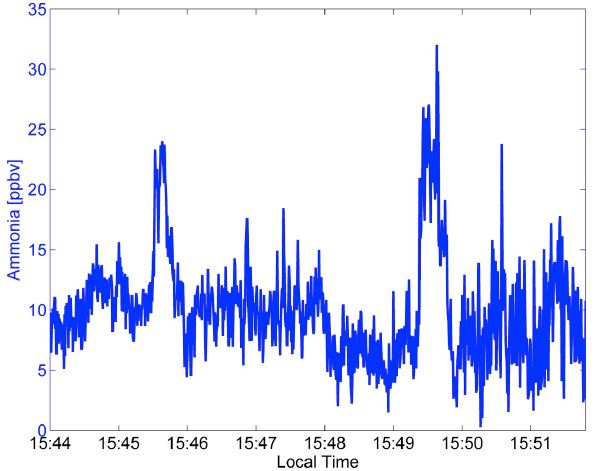
Fig. 10. On-road, mobile, open-path NH 3 measurements of high- Figure 10. On-road, mobile, open-path NH 3 measurements of highway vehicle emissions 2 way vehicle emissions recorded at 2Hz. The response time at recorded at 2 Hz. The response time at ppbv NH 3 mixing ratios is demonstrated for the 3 ppbv NH 3 mixing ratios is demonstrated for the emission spikes emission spikes at 15:45:40 and 15:49:30 local time. 4 at 15:45:40 and 15:49:30 local time.